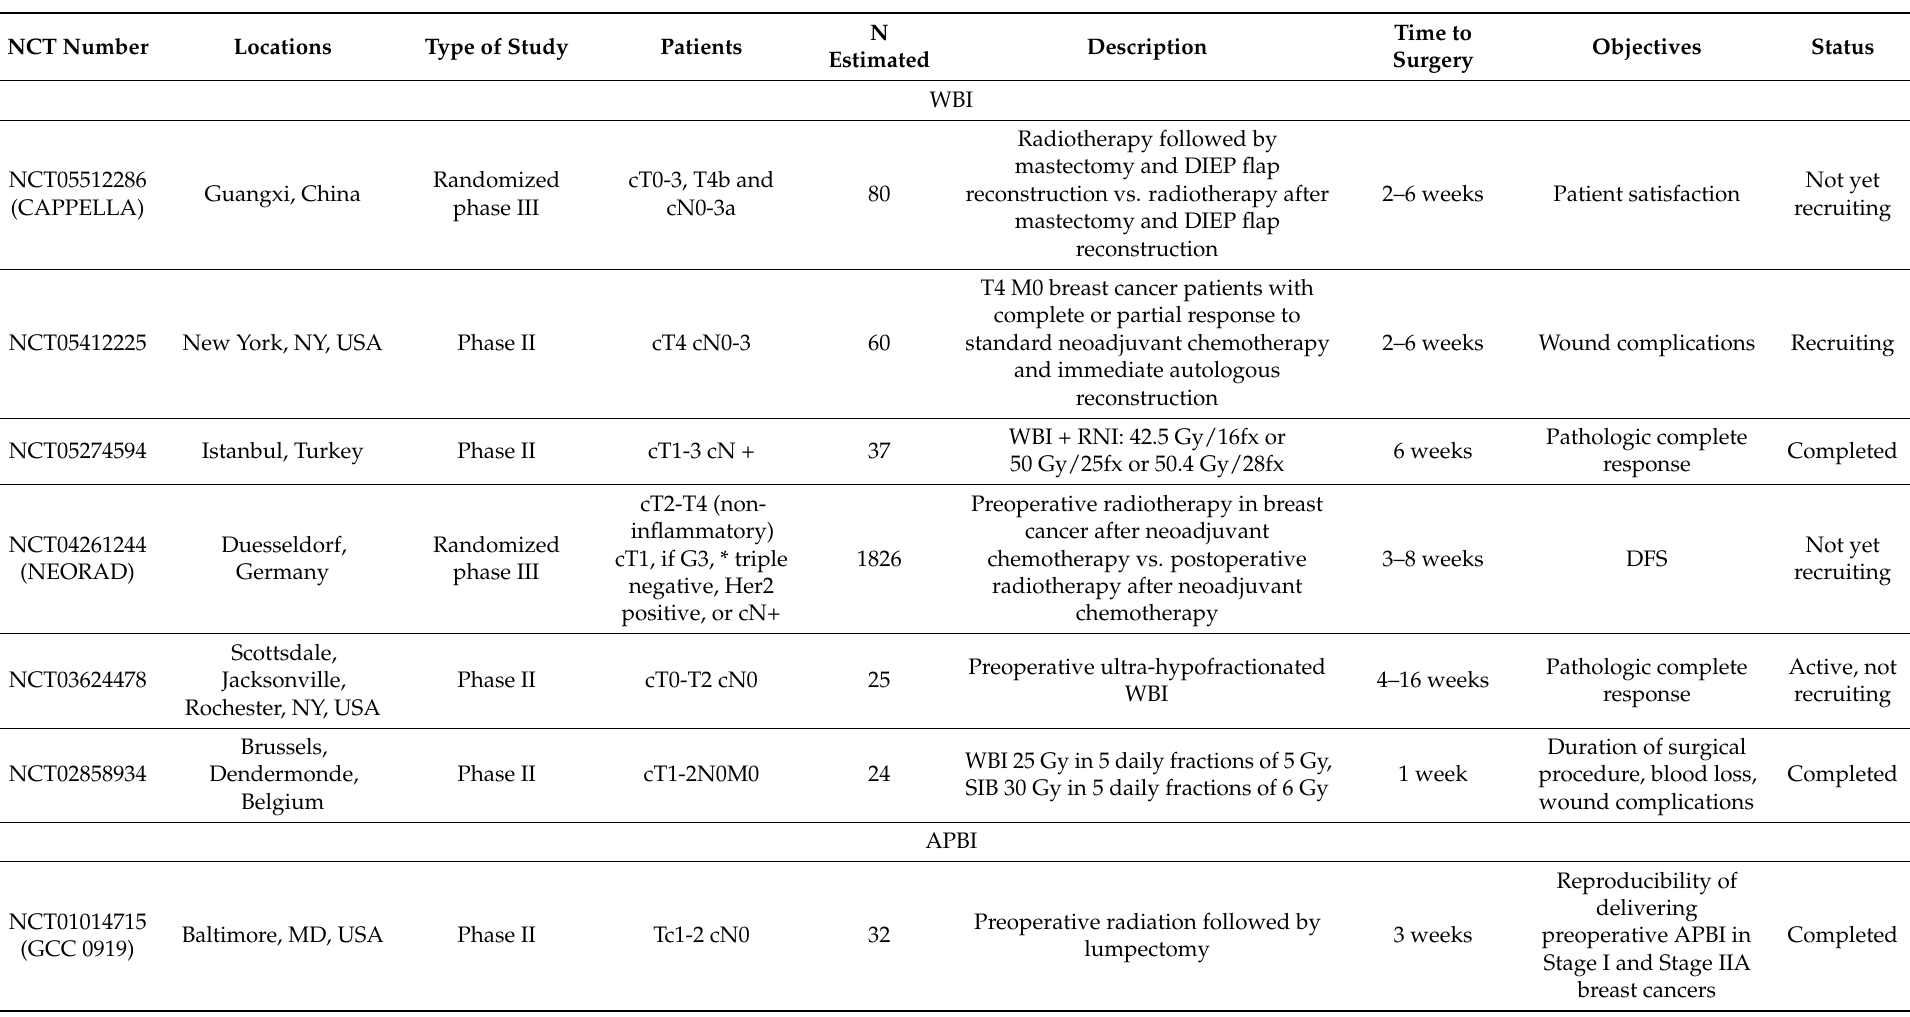
Table 4. Ongoing preoperative RT